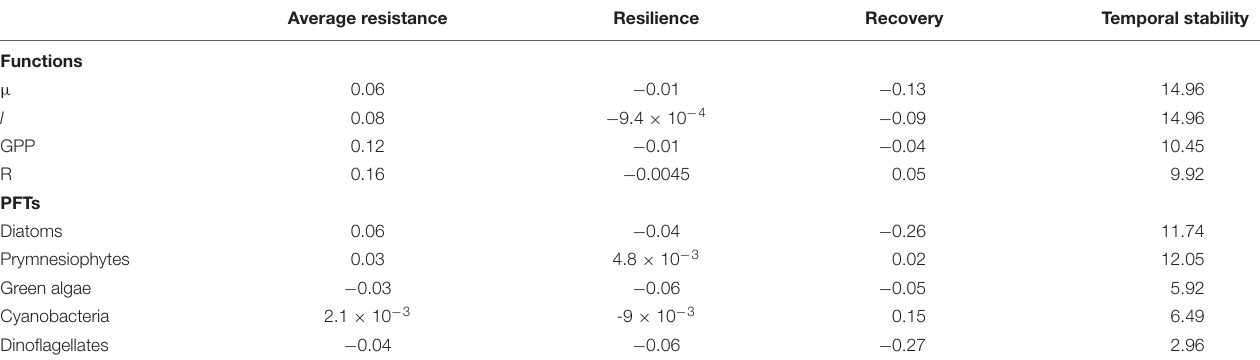
TABLE 5 | Average resistance, resilience, recovery, and temporal stability in terms of µ , l , GPP, R, and PFTs. Average resistance Resilience Recovery Temporal